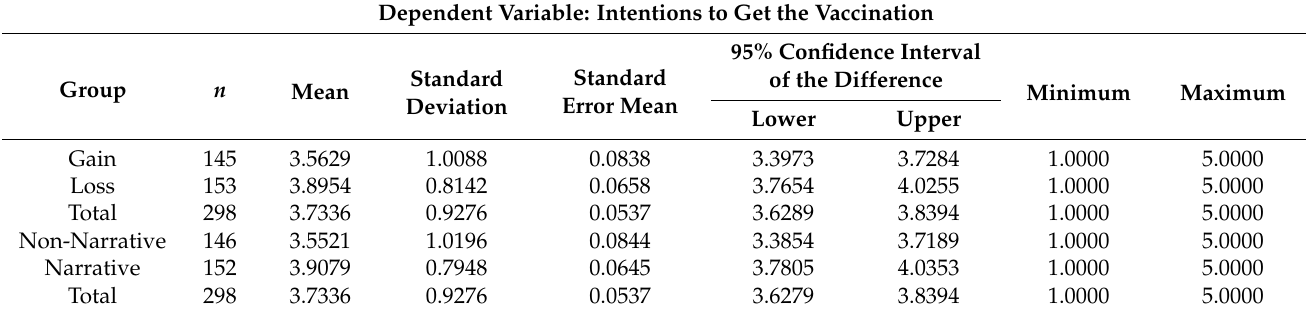
Table 2. Means and standard deviation related to research questions